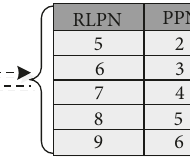
Figure 5: Compression of an entry